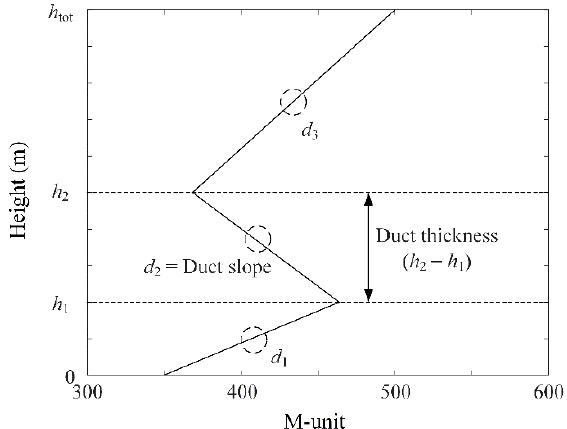
Figure 6. The shape of the tri-linear model.